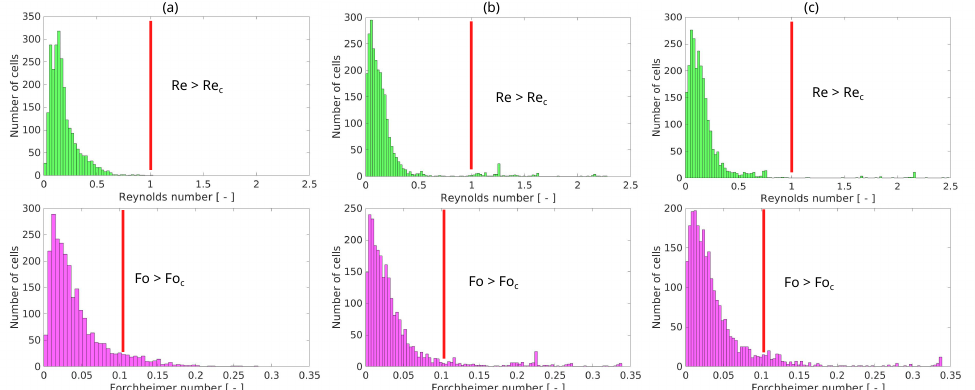
Figure 3. Reynolds ( Re , top ) and Forchheimer ( Fo , bottom ) numbers histograms, calculated with the Darcy velocity values for the three scenarios (a–c). Every column depicts the number of cells for a range [ Re / Fo min , Re / Fo max ) with ∆ Re / Fo = 0.009/0.003. The total number of cells is 2500. The critical Reynolds and Forchheimer numbers are depicted as red vertical